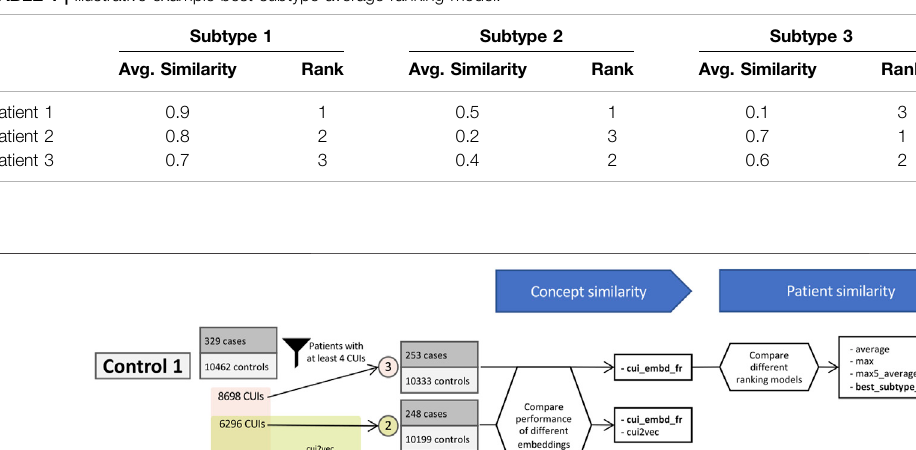
TABLE 1 | Illustrative example best-subtype-average ranking model.